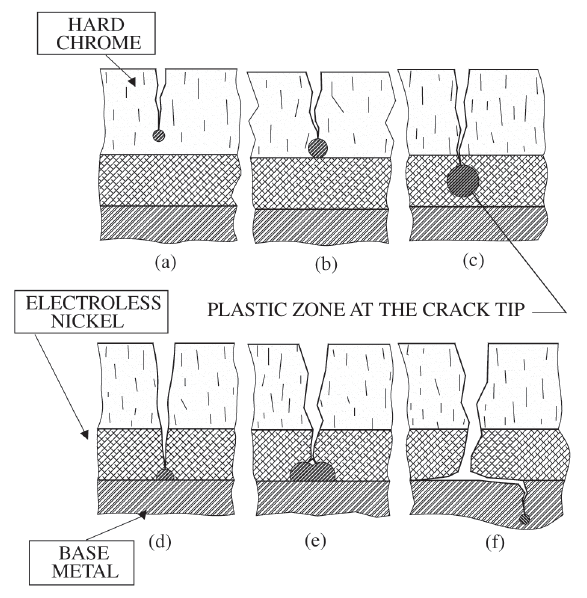
Figure 4. Simulation of the crack propagation in the multilayer system.